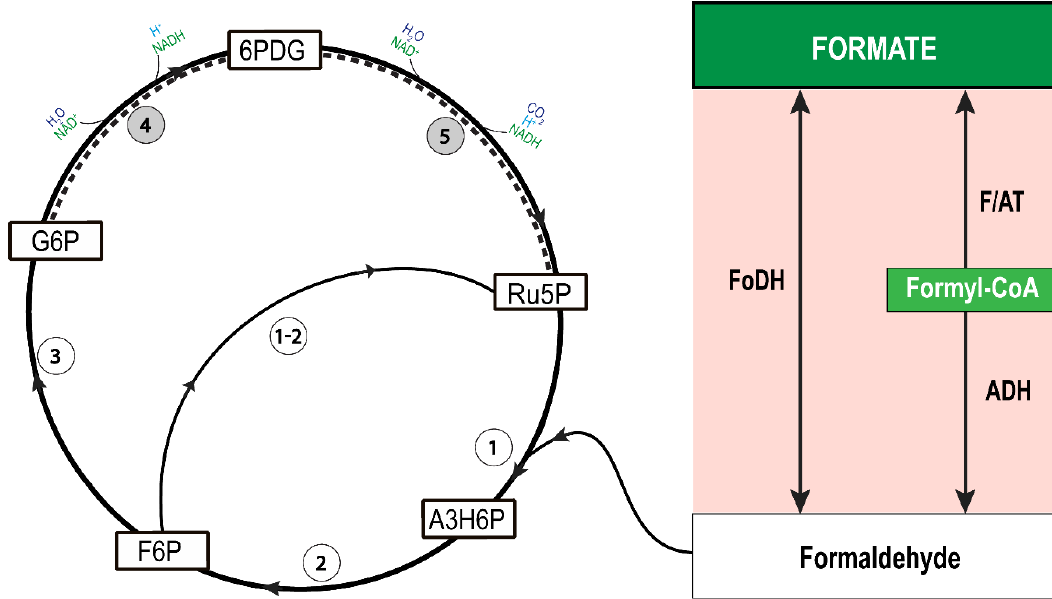
Figure 6. Schematic illustration of the proposed route for formate assimilation in D. amylolyticus . The first part of the cycle is formaldehyde production from formate, which might be catalysed by formaldehyde dehydrogenase (FoDH), or formyl/acetyl transferase (F/AT) and aldehyde dehydrogenase (ADH). The second part of the cycle represents formaldehyde assimilation and ribulose 5-phosphate (Ru5P) regeneration via ribulose monophosphate pathway (RuMP) and oxidative pentose phosphate pathway (OPPP). Formaldehyde could be fixed by Ru5P to form D-arabino-3-hexulose-6-phosphate (A3H6P) by 3-hexulose-6-phosphate synthase (HPS) (1) and then isomerized to fructose 6-phosphate (F6P) by 6-phospho-3-hexuloisomerase (PHI) (2). In the genome of D. amylolyticus, only gene was found for an HPS-PHI-fused bifunctional enzyme (1-2). F6P is further isomerized to glucose-6-phosphate (G6P) by glucose-6-phosphate isomerase (3). Later, G6P is oxidized to Ru5P by glucose-6-phosphate dehydrogenase (4) and 6-phosphogluconate dehydrogenase (5).